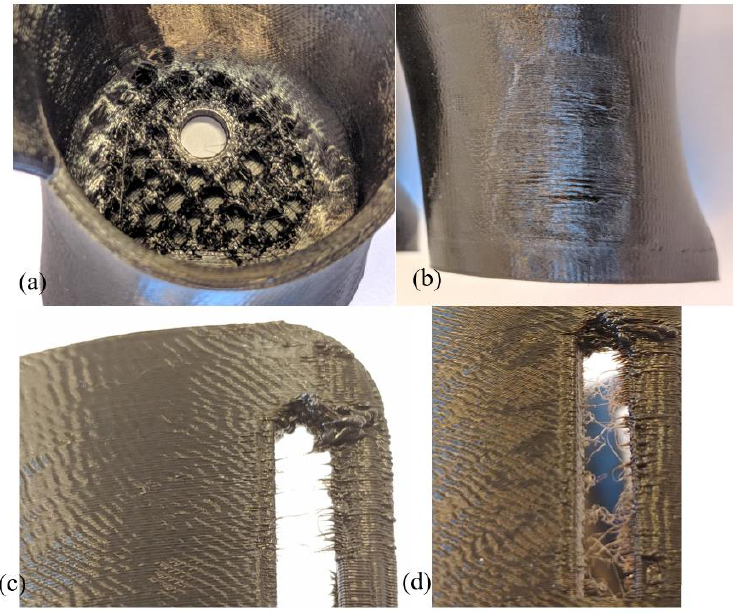
Figure 9. Minor manufacturing errors observed in the studies: ( a ) holes — TPE, ( b ) deformations — PLA, ( c ) deformations — TPE, and ( d ) stringing — TPE.